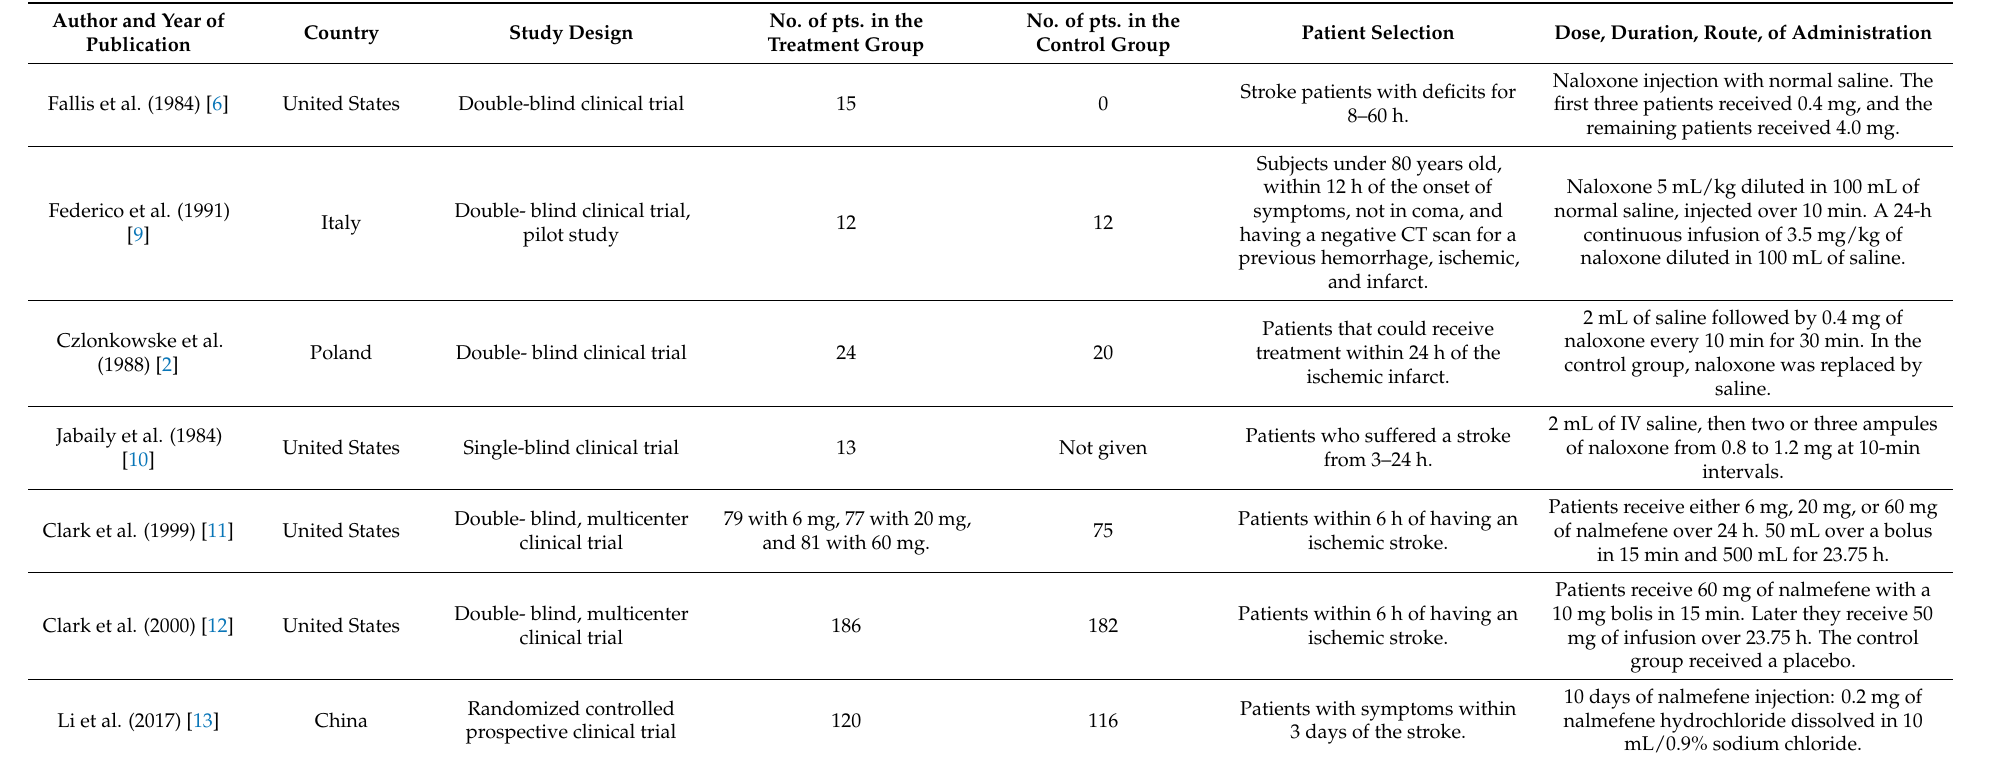
Table 1. Characteristics of clinical